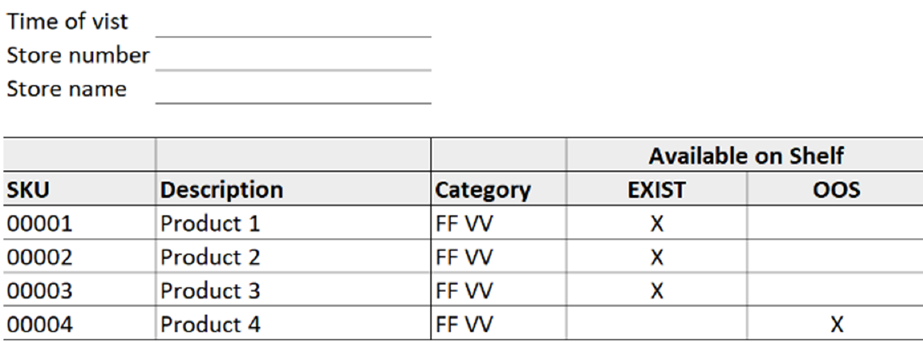
Figure 2. Shelf availability Physical Audit Sheet.